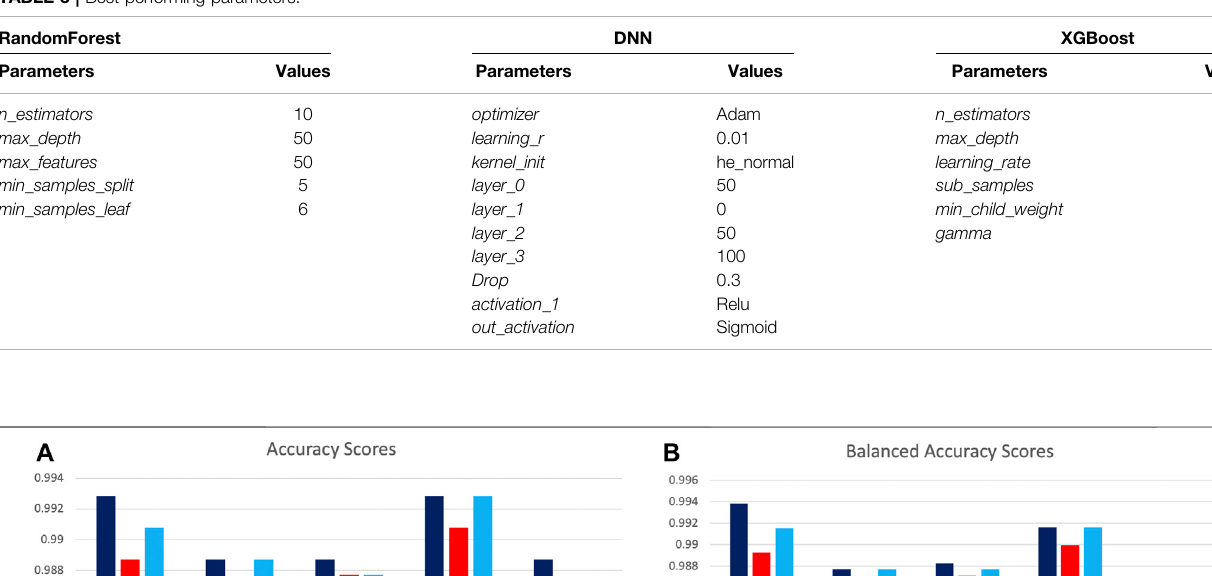
TABLE 3 | Best performing parameters.